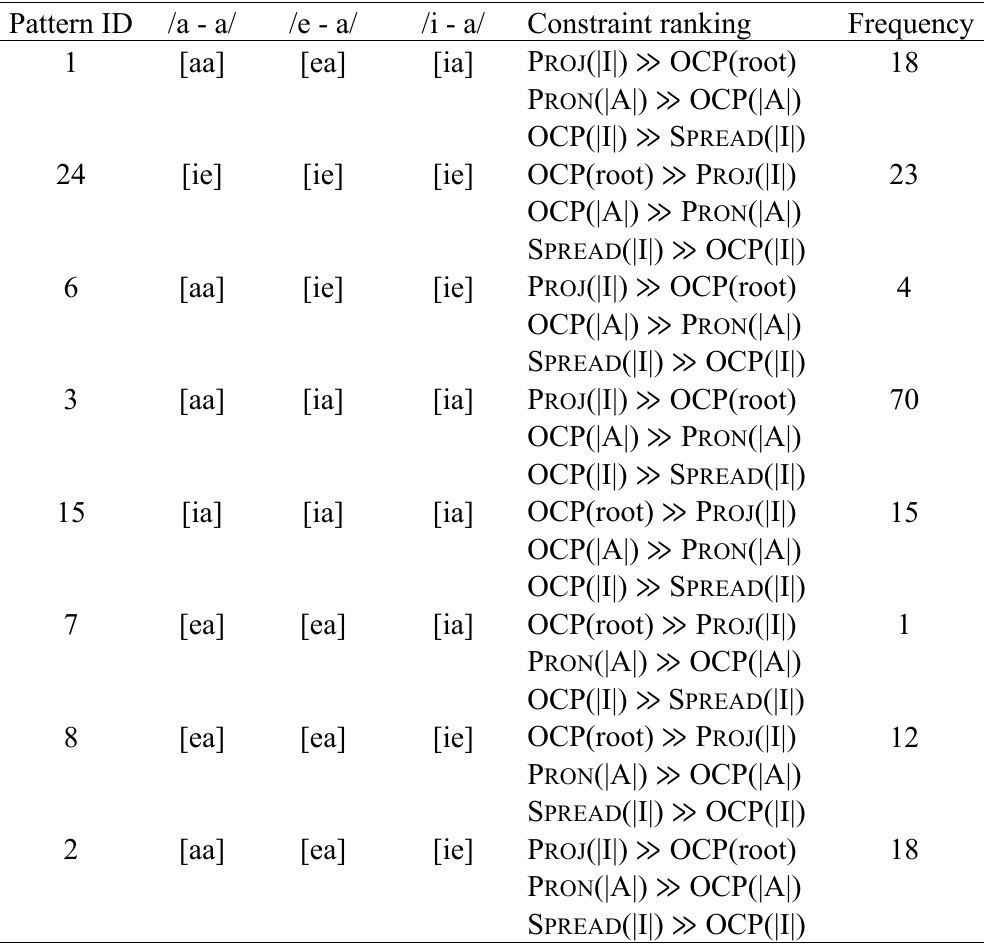
Table 4 . Factorial typology for attested transparent